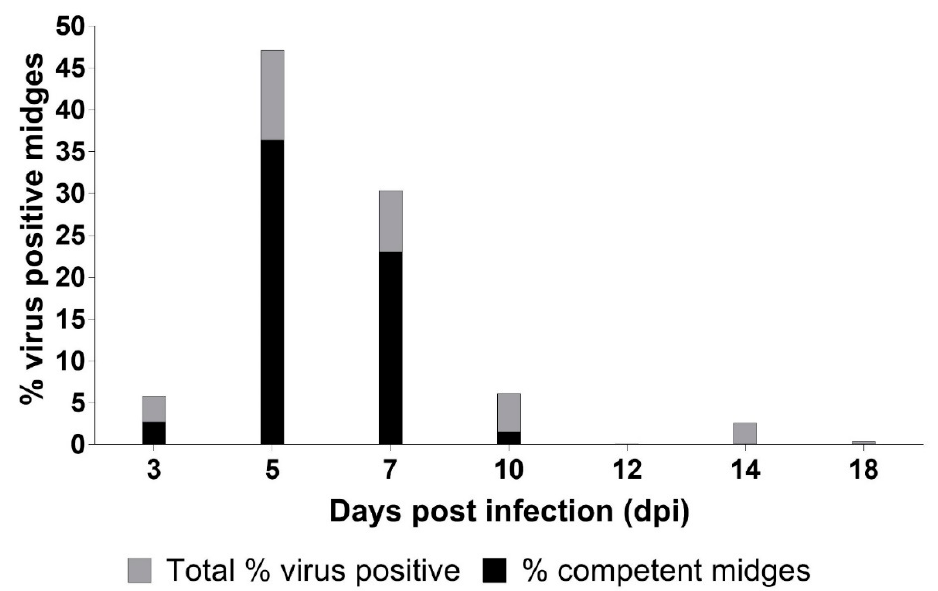
Figure 4. Bar graph showing proportion of epizootic hemorrhagic disease virus serotype 2 positive midges that reached titers > 10 2.7 median tissue culture infective doses (TCID 50 ) / midge and were considered competent to transmit virus. No positive midges were detected at 12 dpi.